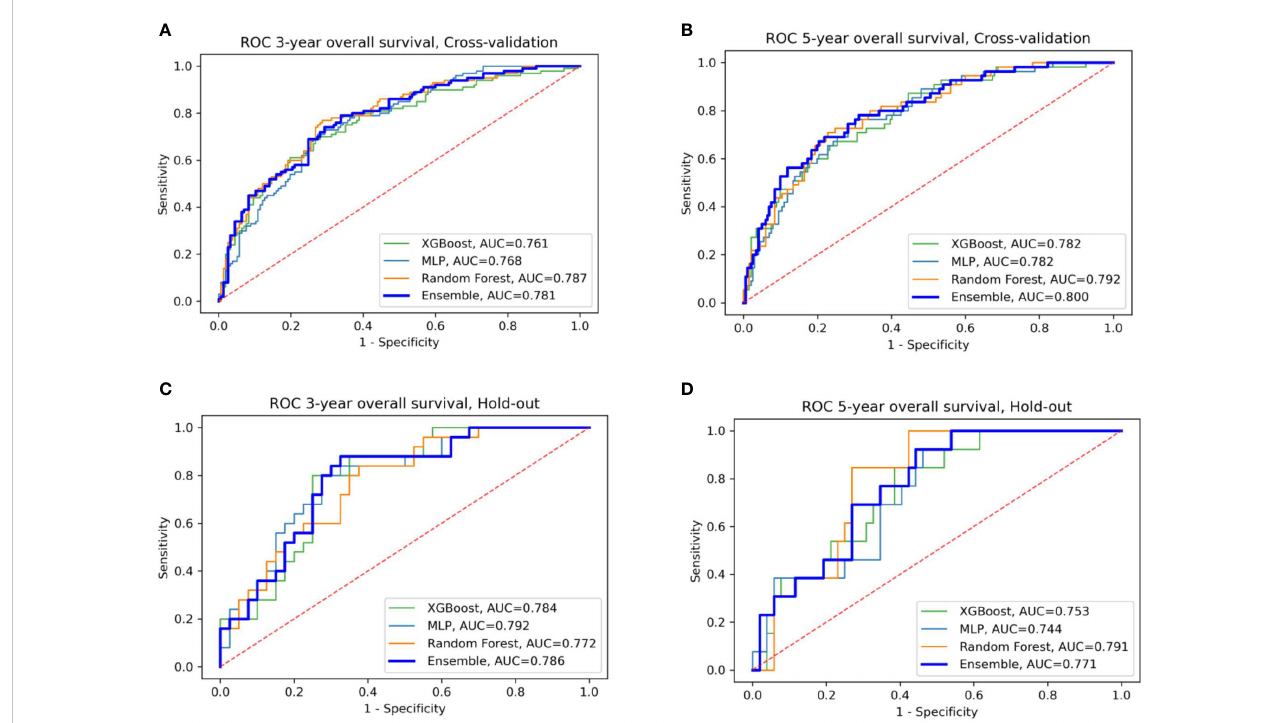
FIGURE 3 ROC curves of the four models: XGBoost, Random Forest, MLP, and their ensemble for prediction of three- and fi ve-year OS (A, B) for cross-validation sets (C, D) for the hold-out